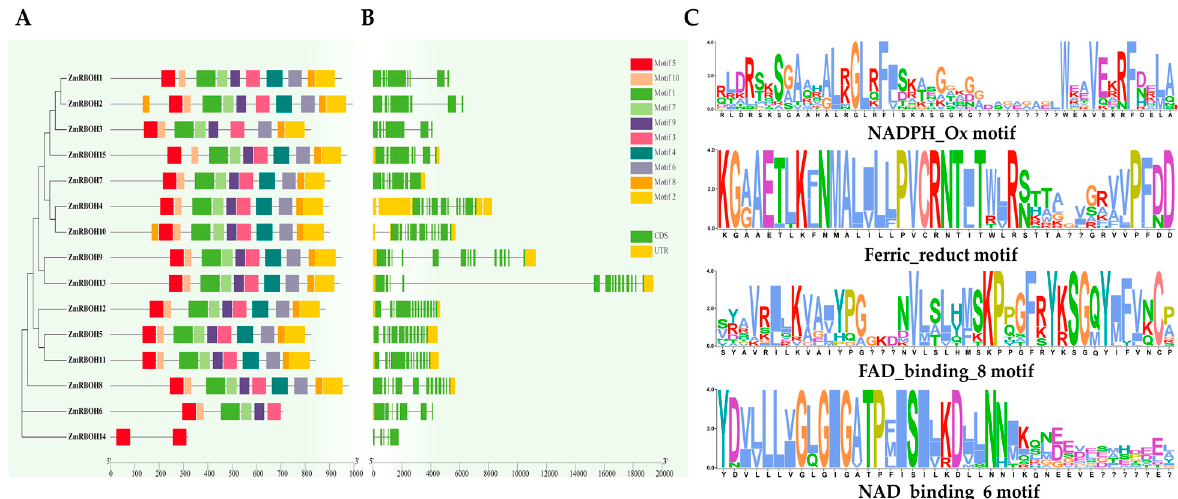
Figure 5. Evolutionary relationships, conserved motifs, and gene structures of ZmRBOH genes. The phylogenetic tree was constructed using MEGA-X by the Neighbour-Joining (NJ) method. ( A ) Conserved motifs in ZmRboh proteins. ( B ) Gene structures of the ZmRBOH genes. Exons, introns, and untranslated regions (UTRs) are indicated by yellow rectangles, gray lines, and green rectangles, respectively. ( C ) Sequence-logos of conserved motifs. The bit score indicates content of each position in the amino acid sequence.